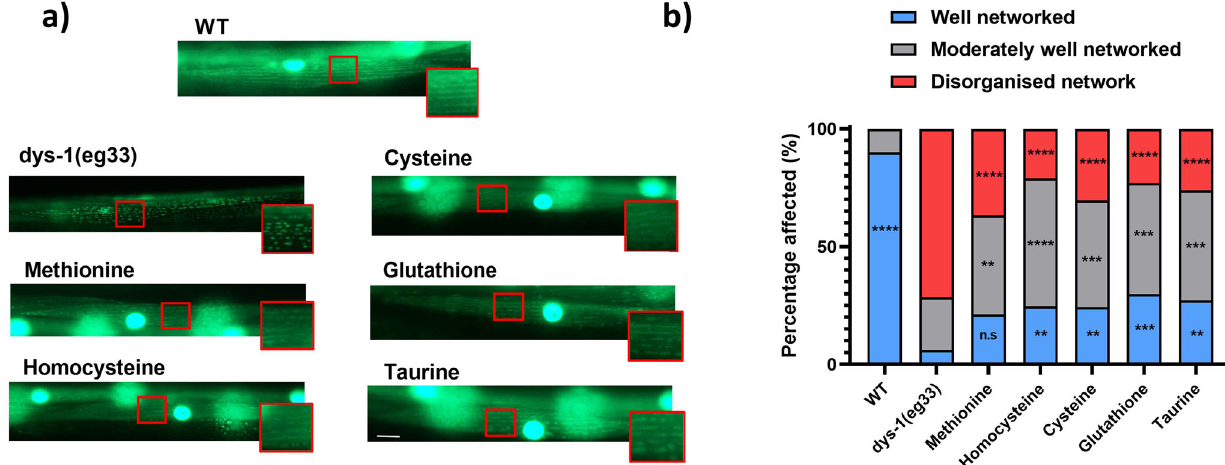
Fig. 4 The mitochondrial network of dys-1(eg33) animals is improved by SAA treatment. a Representative images of CB5600 ( wt ) with GFP tagged mitochondria which displayed a well organised mitochondrial network. CC91 ( dys-1(eg33) with GFP tagged mitochondria which showed a severely disorganised mitochondrial network. L-homocysteine (10 µ M), L-cysteine (10 µ M), L-glutathione (100 µ M) and L-taurine (10 µ M), all signi fi cantly improved the proportion of well-networked mitochondria, and also reduced the degree of disorganised networks to dys-1(eg33) animals, but not to wt levels. L-Methionine (10 mM) did not signi fi cantly increase well-networked proportions, but did offset the prevalence of disorganised networks to dys-1(eg33) . b A stacked bar graph showing the percentage of well-networked, moderately well-networked and disorganised network within each group. Scale bar: 30 µ m. Data are means from 20 animals across two biological